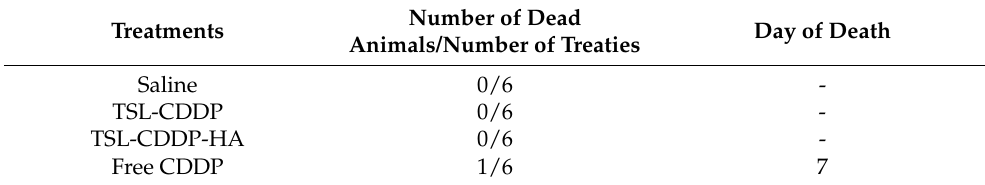
Table 3. Mortality of mice over the 14 days of the experiment. Treatments